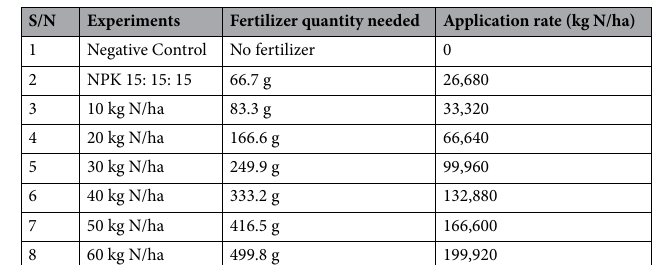
Chemical properties Microbial composition Parameter